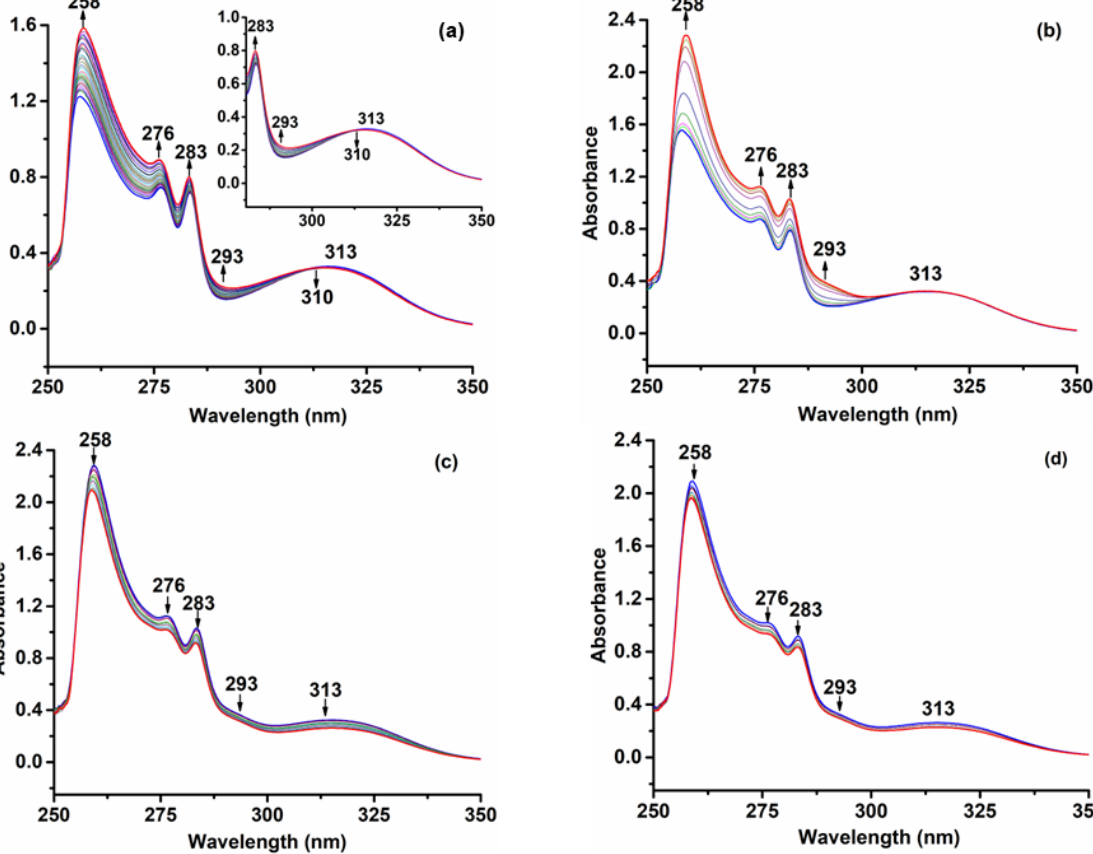
Figure 7. ( a ) Spectral changes observed after the successive addition of one drop portion of 30% H 2 O 2 dissolved in 10 mL of DMSO (final concentration of H 2 O 2 solution: 9.5 × 10 –2 M) to 10 mL (2 × 10 –4 M) solution of [V V O 2 (sal-aebmz)] ( 1 ) in DMSO. ( b ) Spectral changes observed after successive